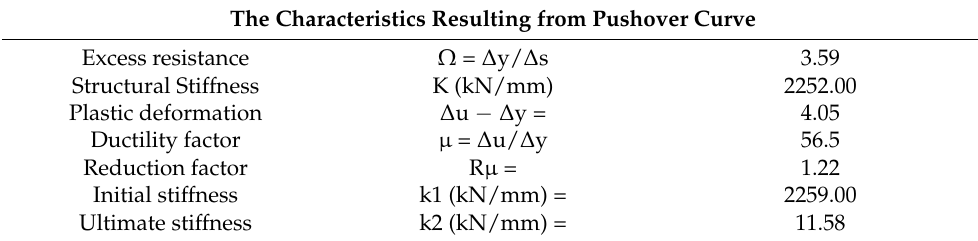
Table 3. The characteristics resulting from pushover curve.